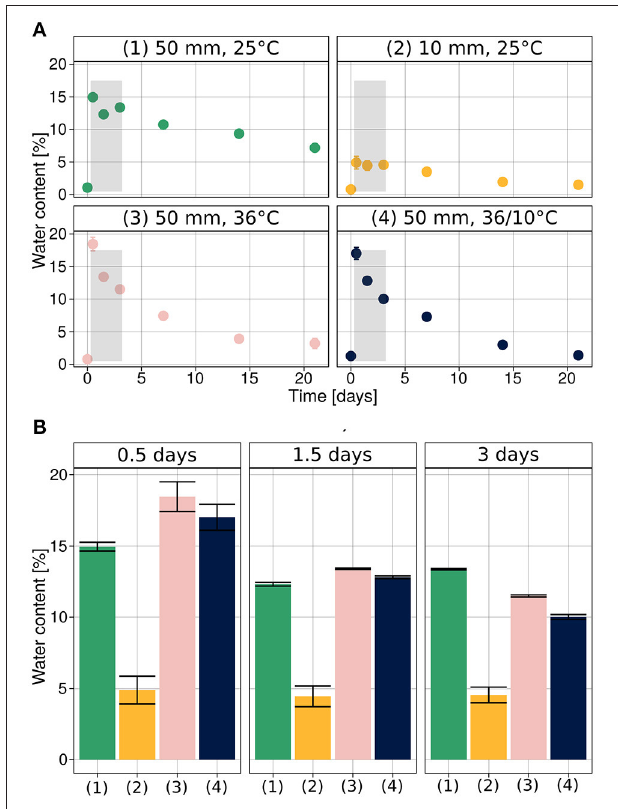
FIGURE 2 | Soil water content during hydration–desiccation. (A) Under each of the experimental conditions. (B) Direct comparison of the four treatments for the first three sampling times after wetting. Average values are presented as mean ± SEM, based on 12 observations per data point.